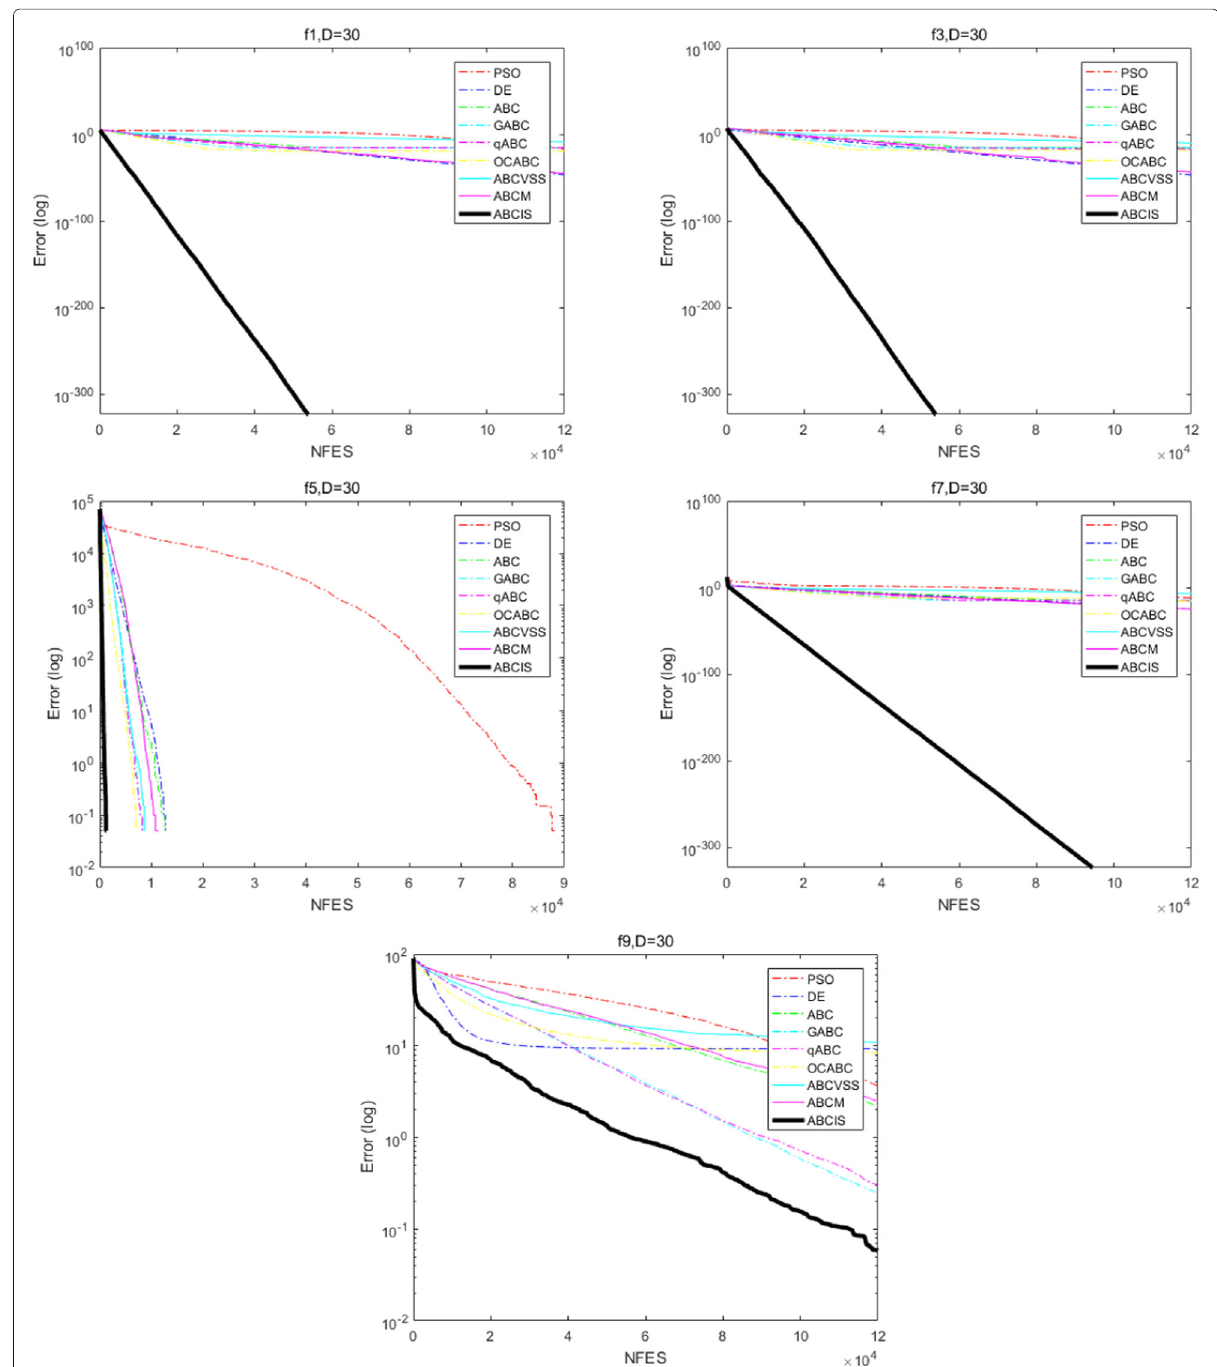
Fig. 4 Convergence curves, D =